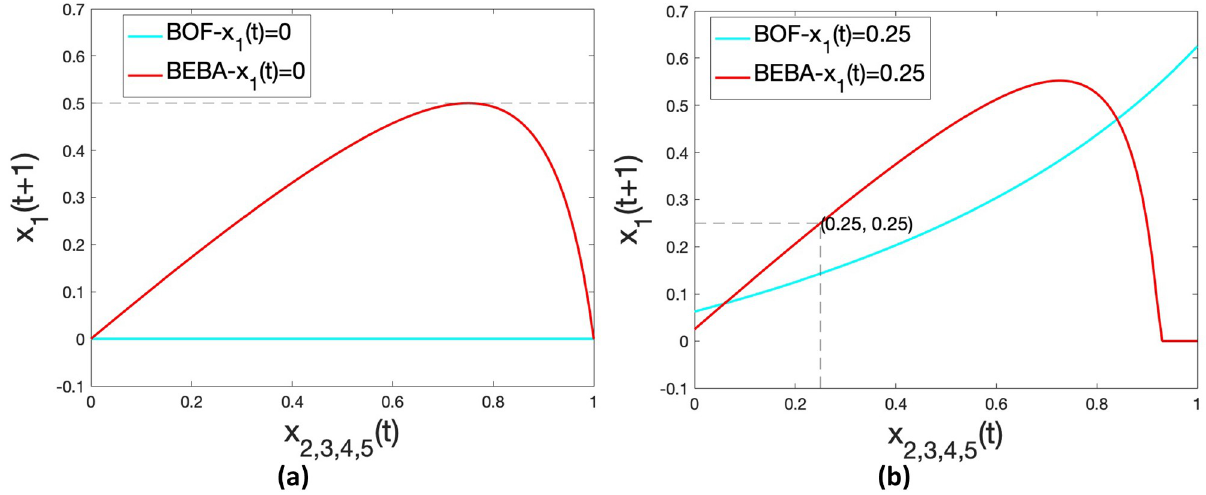
Fig 2. x 1 ( t + 1) as a function of x 2,3,4,5 ( t ). (a) β 1 = 1, b 1 = 1, x 1 ( t ) = 0; (b) β 1 = 2.5, b 1 = 1, x 1 ( t ) = 0.25.